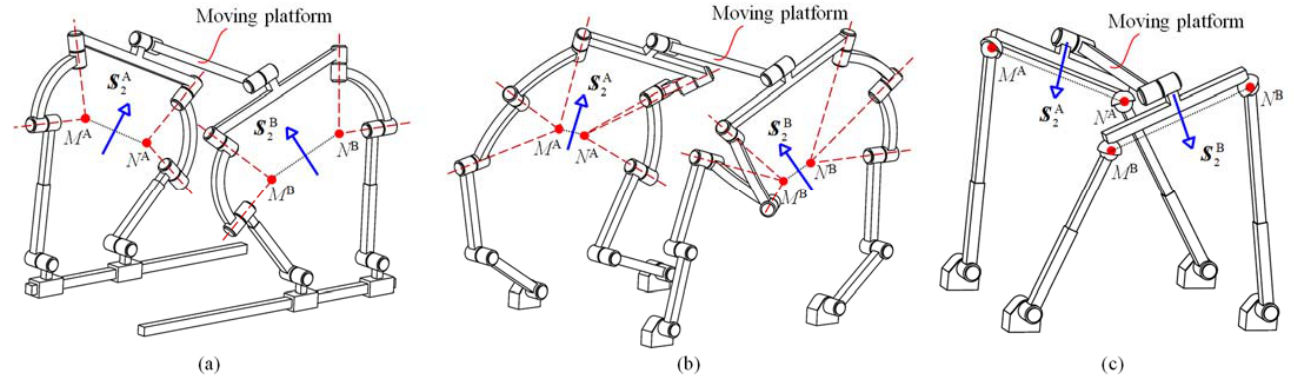
Figure 8. Typical non-overconstrained 1R3T PMs: ( a ) 2([PR 1 PR M R M -PR 1 PR N R N ]-R MN )